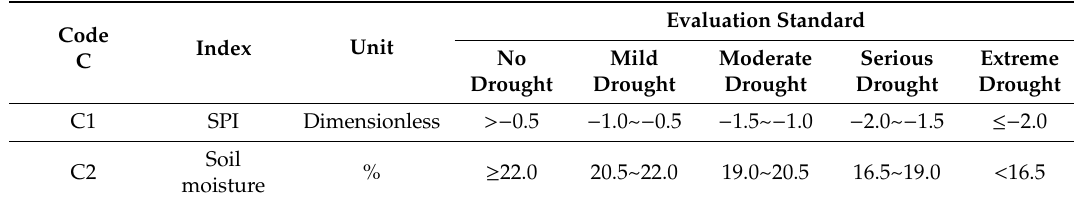
Table 1. Classification of drought grades according to evaluation